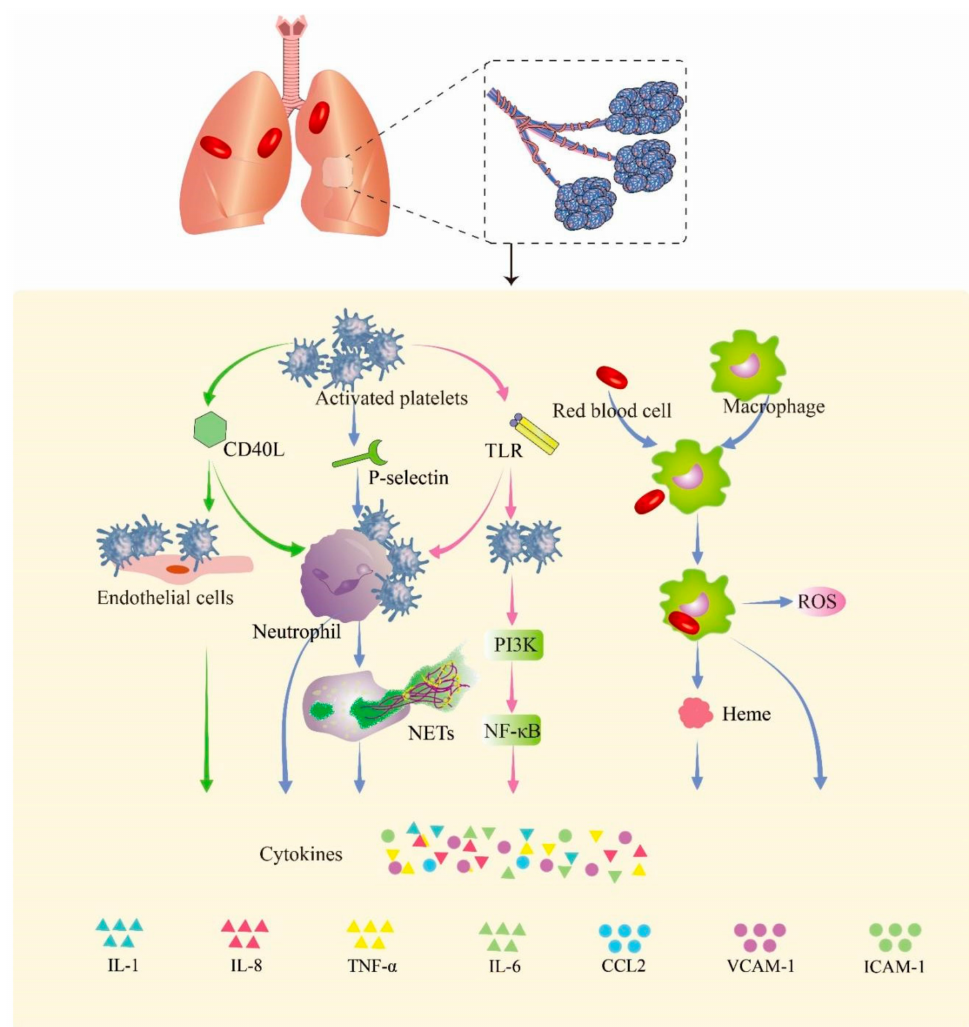
Figure 2. Hemorrhage promotes inflammation in PBLI. Activated platelets express a variety of cell surface proteins such as CD40Ls, P-selectins, and TLRs to trigger inflammation responses. The p-selectin expressed by activated platelets mediates the binding of platelets to neutrophils. CD40L mediates the binding of platelets to endothelial cells and neutrophils. The expression of TLRs in platelets promotes binding with neutrophils. Upon binding, neutrophils, endothelial cells, and activated platelets initiate an inflammatory response that promotes the release of cytokines. The red blood cells that leak into the alveoli are swallowed by macrophages and release heme and globulin. Heme induces the release of ROS and activation of the NF- κ B signaling pathway in macrophages, thereby triggering inflammation. CD40L: cluster of differentiation 40 ligand; NETs: neutrophil extracellular traps; TLR: Toll-like receptor; PI3K: phosphoinositide 3-kinase; NF- κ B: nuclear factor kappa B; ROS: reactive oxygen species; IL-1: interleukin-1; IL-8: interleukin-8; TNF- α : tumor necrosis factor- α ; IL-6: interleukin-6; CCL2: C–C motif chemokine ligand 2; VCAM-1: vascular cell adhesion molecule 1; ICAM-1: intercellular adhesion molecule